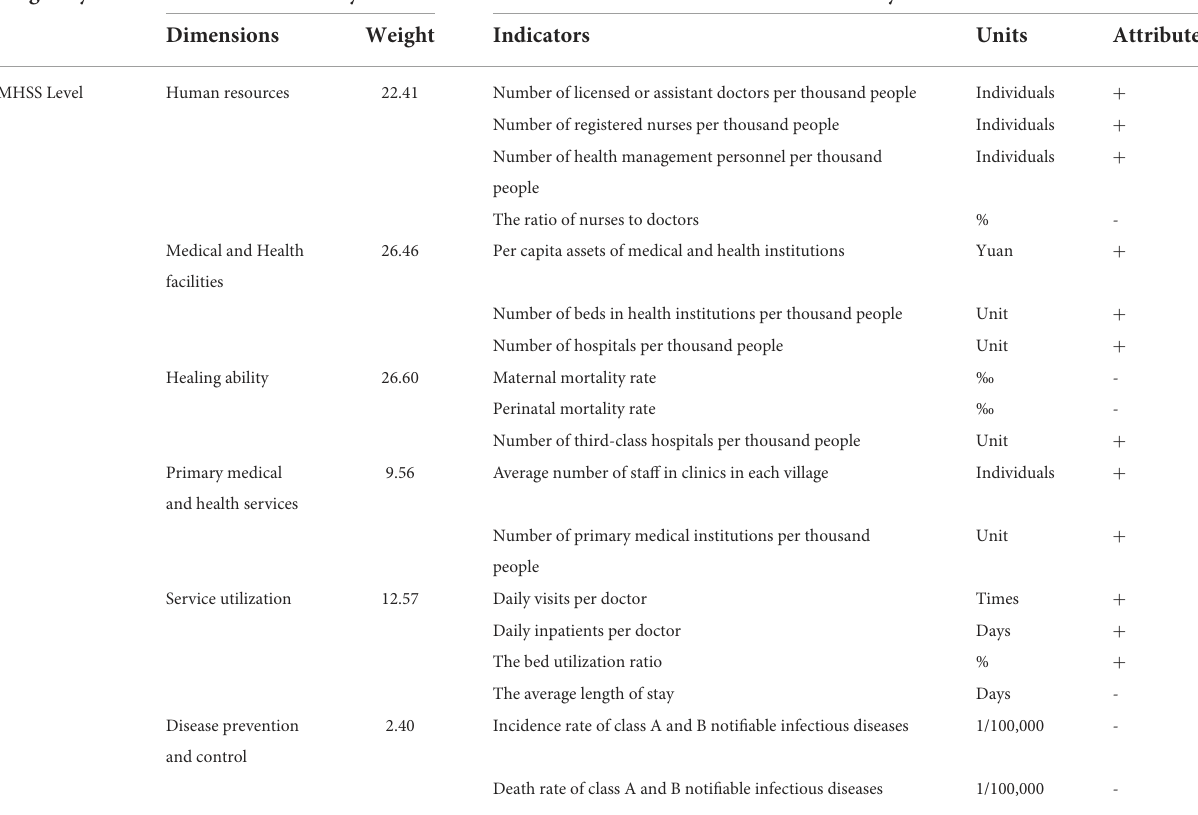
TABLE 1 Evaluation index system of the MHSS